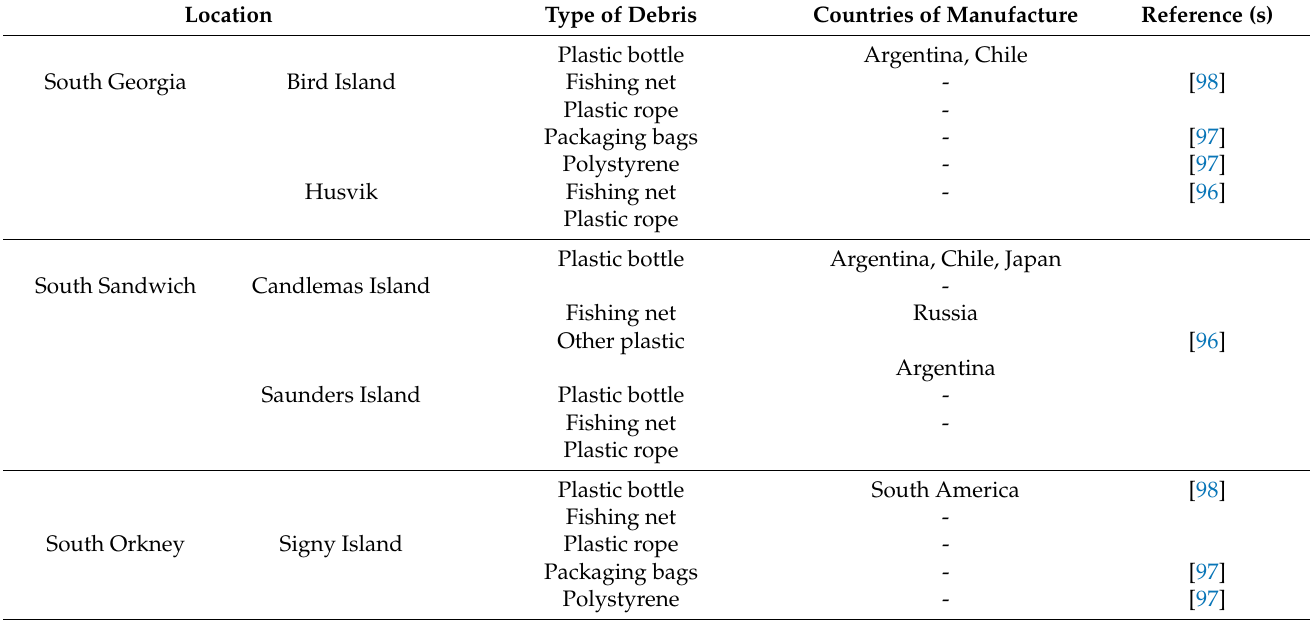
Table 5. Beached marine debris found in remote areas in